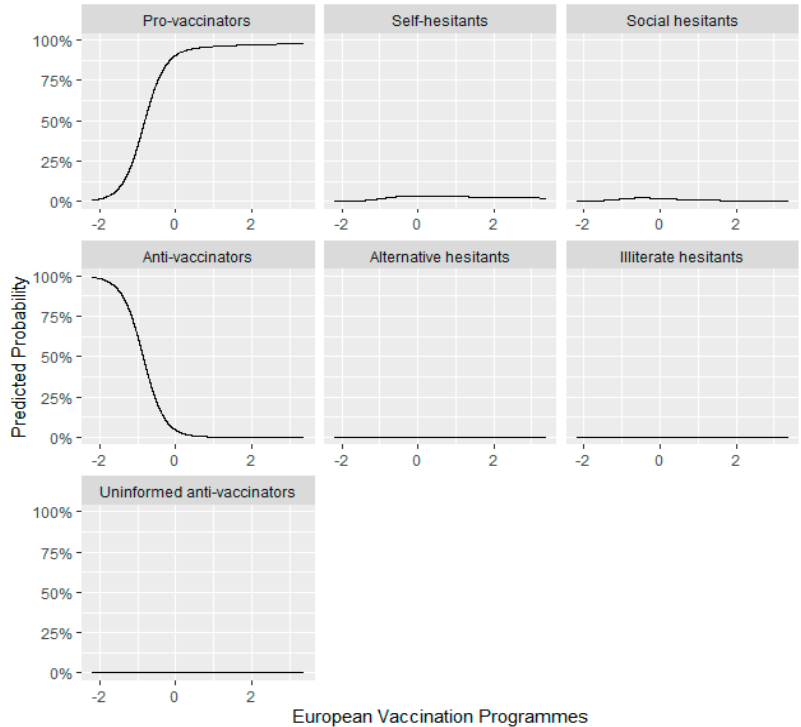
Figure A9. Marginal Effects Multinomial Logistic Regression. European Vaccination Programs.